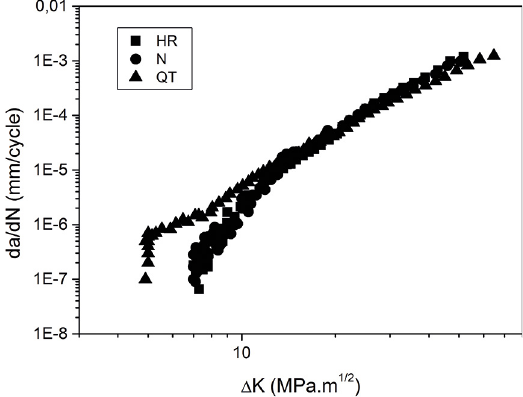
Figure 5. Fatigue crack growth results. HR = hot-rolled; N = normalized; QT = quenched and tempered.